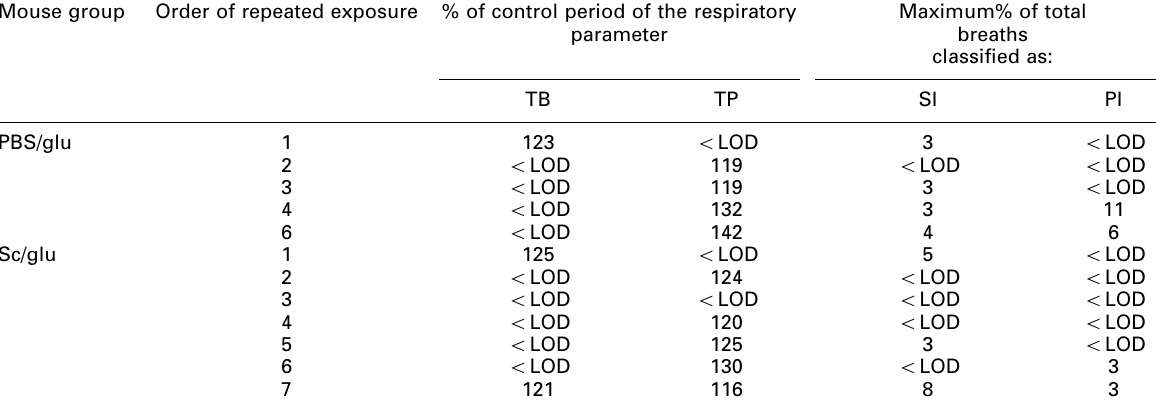
Table 4. Respiratory effects of seven b -glucan inhalation exposures on four BALB/cJBom mice Mouse group Order of repeated exposure % of control period of the respiratory parameter